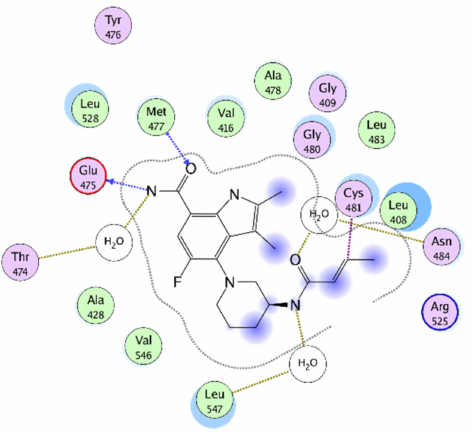
Figure 3. Ligplot of the BTK-Branebrutinib crystallographic complex (PDB code: